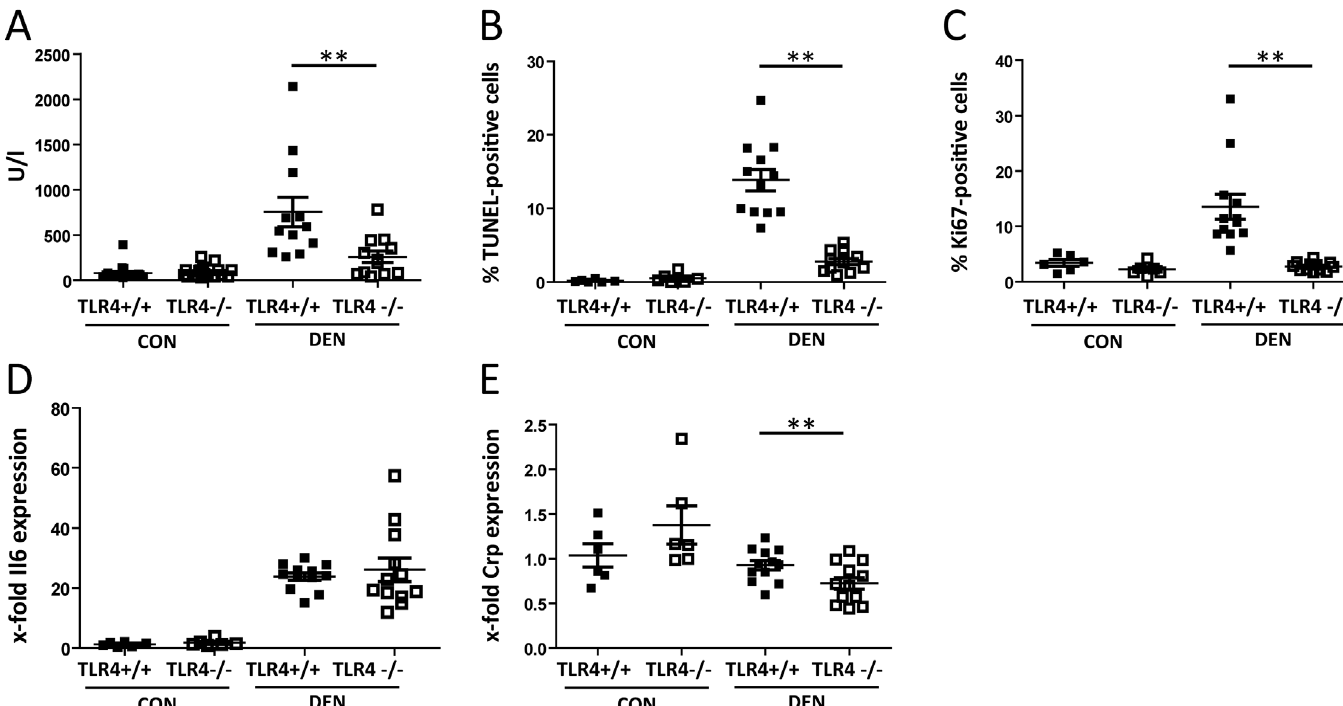
Fig 2. DEN-induced liver injury is reduced in the absence of TLR4. TLR4- sufficient and deficient animals at the age of 16 weeks were subjected to DEN for 48 hours (DEN, n = 12 per line; 6 males, 6 females) and compared to untreated controls (CON; n = 16per line; 3 males, 3 females). (A) Plasma ALT activities, measured in U/l. (B) Hepatocellular apoptosis rates. (C) Hepatocellular proliferation rates. (D) Relative hepatic Il6 expression. Untreated TLR4-sufficient mice were set as 1. (E) Relative hepatic Crp expression. Untreated TLR4-sufficient mice were set as 1. ** p <